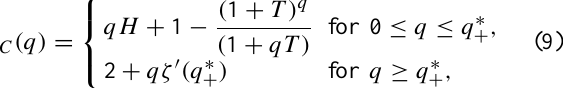
respect to velocity increments in K62 theory of